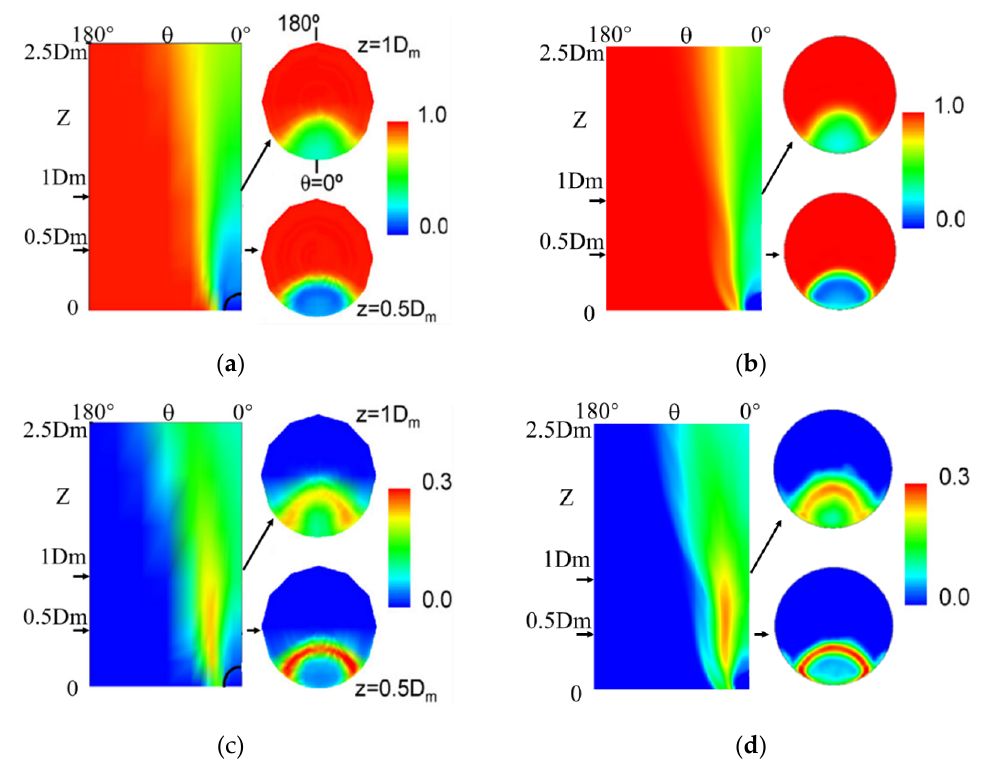
Figure 6. Temperature distribution downstream of W-ref case using LES and ELES: ( a ) Temperature T * distribution using LES; ( b ) Temperature T * distribution using ELES; ( c ) Temperature T sd* distribution using LES; ( d ) Temperature T sd* distribution using ELES.